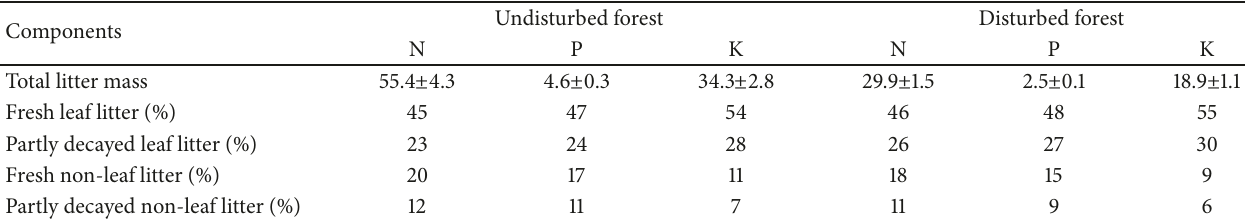
Table 11: Standing state of nutrients (kg ha – 1 ) (mean ± SE) in litter layer in undisturbed and disturbed stands of moist tropical forest in Sunsari district, eastern Nepal.